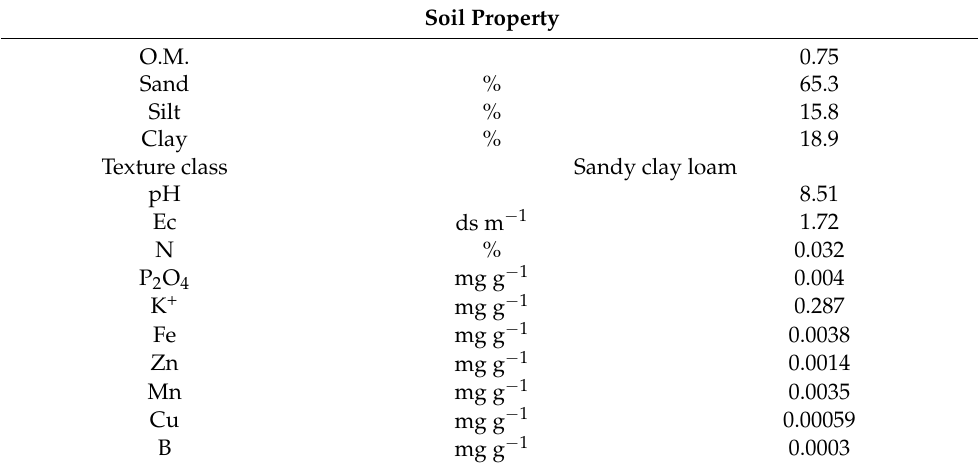
Table 12. The physical and chemical properties of the experimental